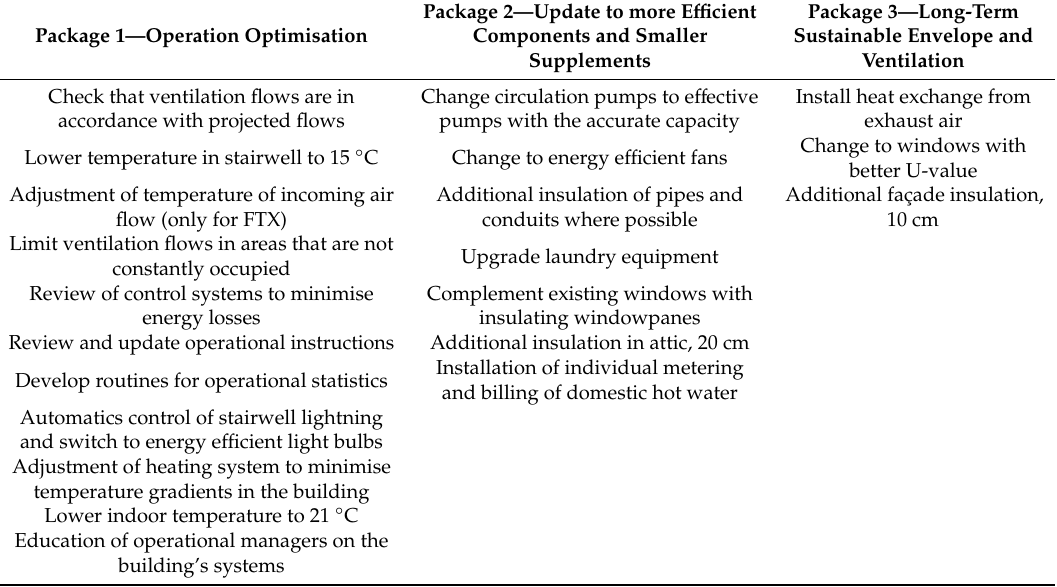
Table A1. An overview of the three energy retrofitting packages (1–3) in the Reference [28] and the energy conservation measures in each of these